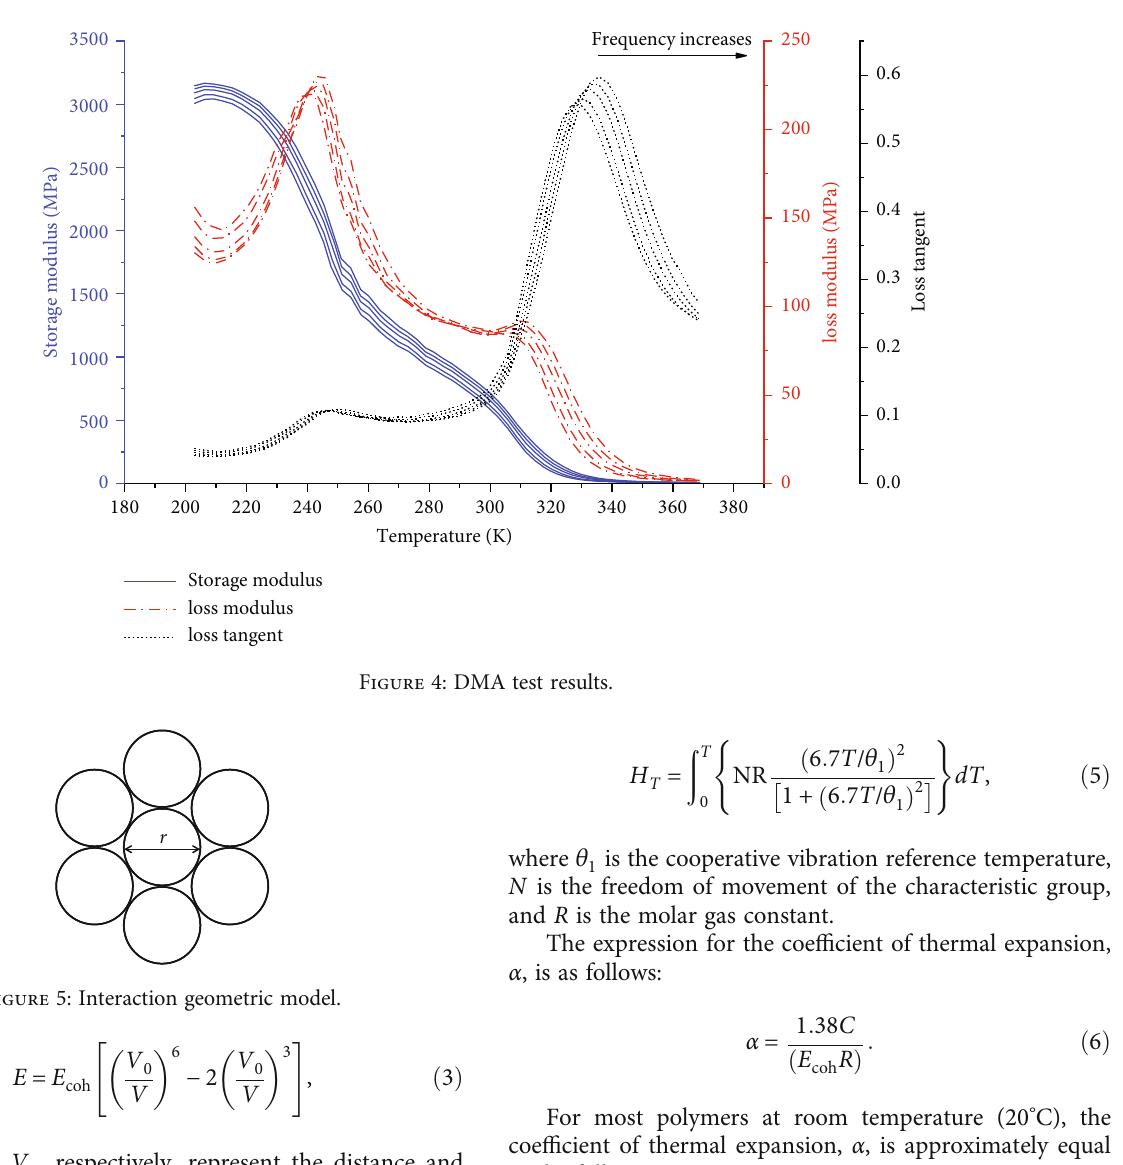
Figure 4: DMA test results.